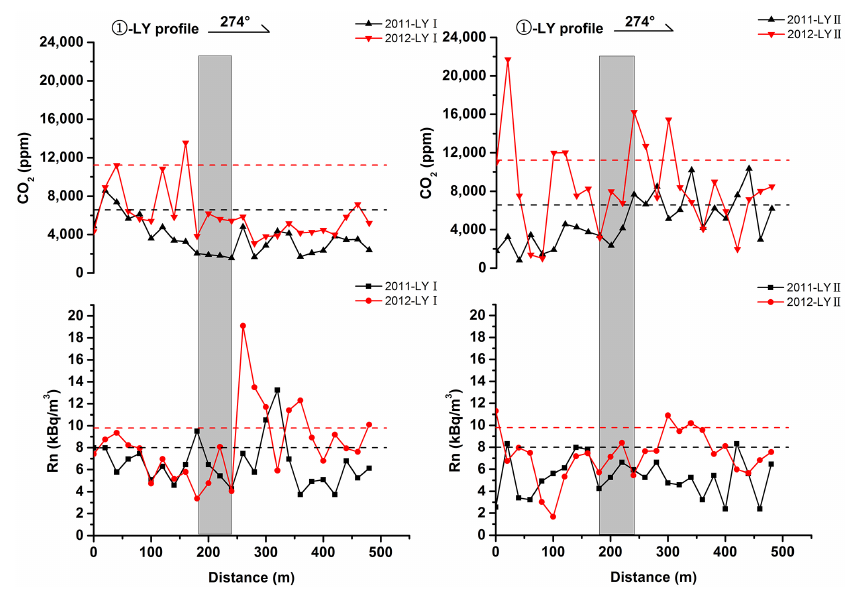
Figure 4. Rn and CO 2 concentrations along the LY profile across the NEYF Fault. The shaded bar represents the location of the fault. The black and red dotted lines represent the anomaly threshold of soil gas in 2011 and 2012, respectively. The arrow at the top (with number above) represents the direction of the profile.